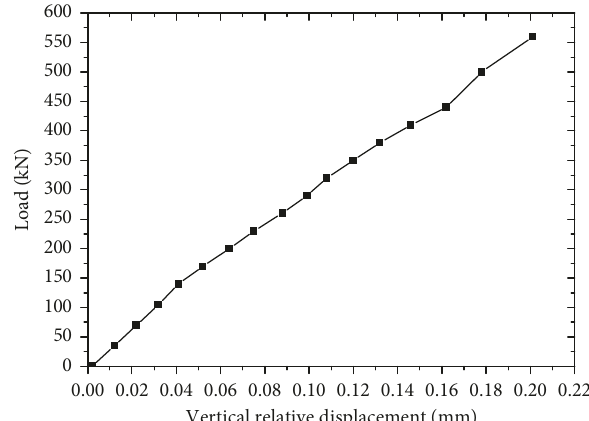
Figure 14: Load-vertical relative displacement curve at the hinge joint.